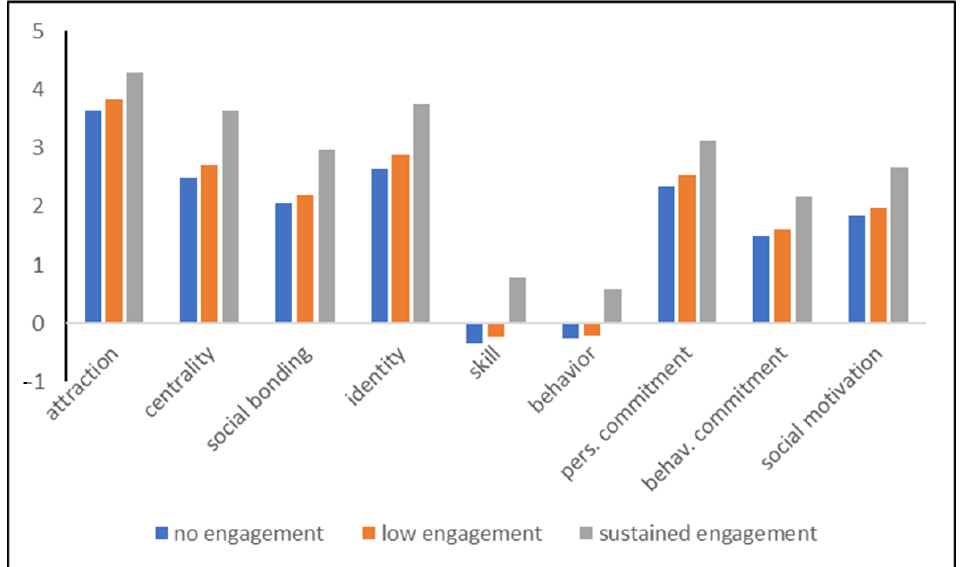
Figure 3. Mean values of the different scales according to the three engagement clusters of CS programs.